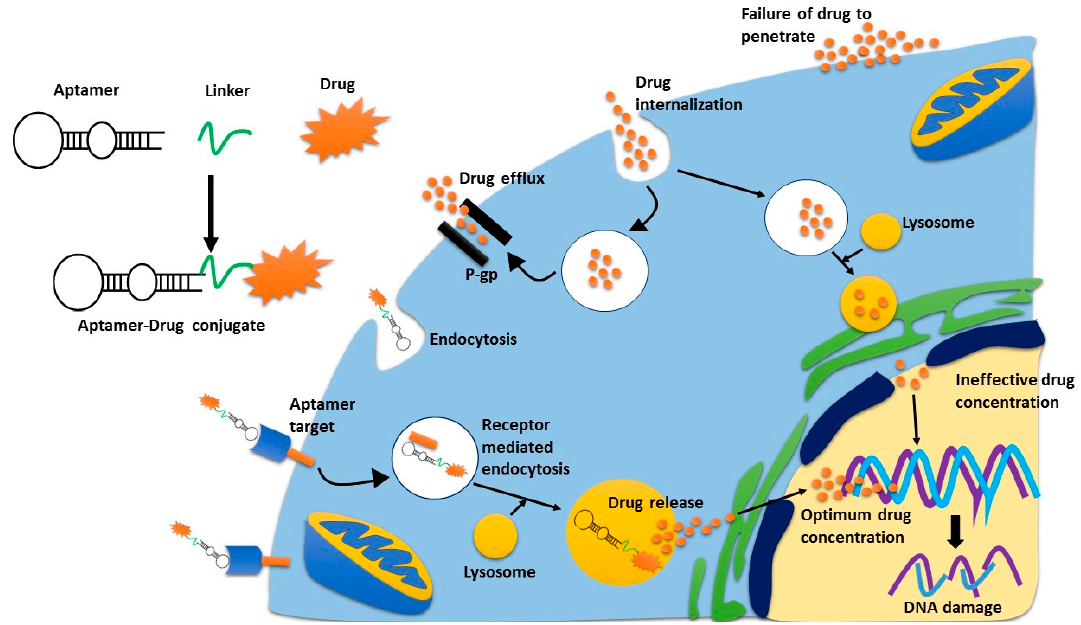
Figure 2. Receptor mediated endocytosis of cytotoxic agents. Aptamer-drug conjugates bind to their receptor, and are trafficked into the cell via receptor mediated endocytosis. Once in the lysosome, the drug is released from the aptamer and is then excreted from the lysosome where it can then move to the nucleus. If the drug is internalised non-specifically, drug-efflux pumps can pump the drugs outside the cell quickly, thus limiting their concentration inside the cell. This is the same process whereby antibody-drug conjugates can deliver a superior concentration of drug, as compared to non-specific cytotoxic drugs.